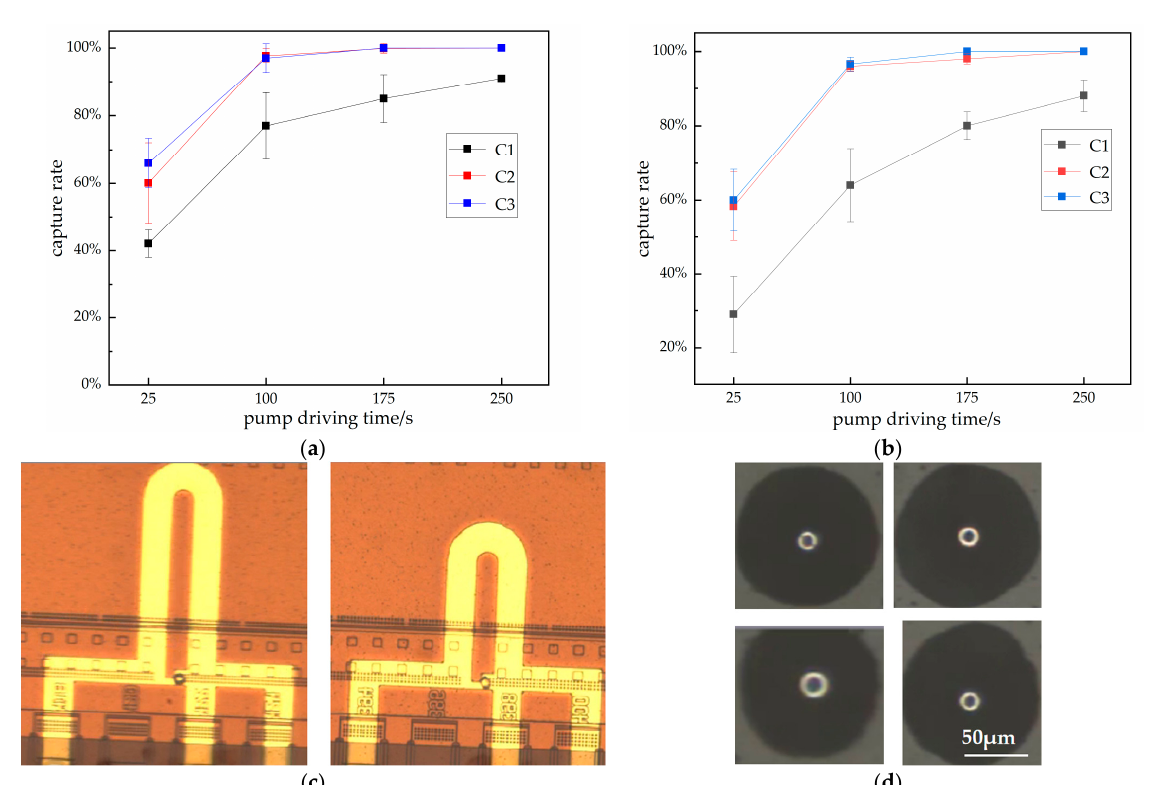
Figure 7. The relationship between the capture rate of microspheres with different concentrations and pump driving times. The longer the micropump’s driving time, the more liquid the capture module flows through. This means more cells flow through the trapping module. ( a ) Capture rate curve of the long bypass channel; ( b ) capture rate curve of the short bypass channel; ( c ) image of a